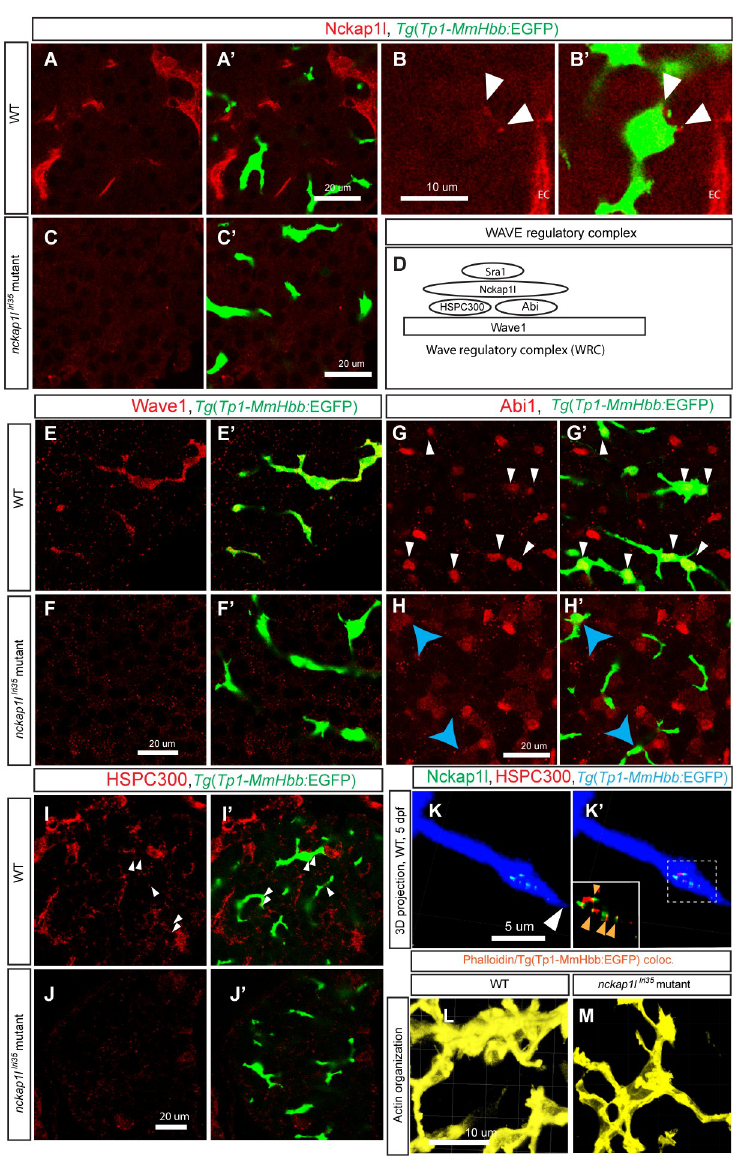
Fig 3. Expression of Nckap1l and other WRC proteins in the liver of wild-type and nckap1l lri35 mutant larvae. (A-C) Z-plane confocal images of the liver visualized for Nckap1l (Red) expression in wild-type (WT) (A and B) and nckap1l lri35 mutant (C) larvae at 5 dpf. Overlay images with biliary epithelial cell marker Tg(Tp1-MmHbb :EGFP ) um14 (Green) shown separately in (A’-C’). Nckap1l is predominantly expressed in endothelial cells in the liver (A), but higher magnification z-plane image (B) shows that Nckap1l is also localized in biliary epithelial cells (white arrowheads). Nckap1l expression is missing in the liver of nckap1l lri35 mutant larvae (C). Ventral views, anterior to the top. EC, endothelial cells. (D-H) Components of the WAVE regulatory complex are degraded in biliary epithelial cells of nckap1l lri35 mutant larvae. (D) Schematic drawing of the WAVE regulatory complex (WRC). This complex acts downstream of Cdk5 and activated Rac1 to stimulate actin remodeling through the actin regulatory complex. The WAVE regulatory complex is a pentameric heterocomplex that consists of WAVE (1, 2 or 3), Abi (1 or 2), Sra1, Nckap1l (or Nap1), and HSPC300. (E and F) Z-plane confocal images of the liver visualized for WAVE1 expression (Red) in WT (E) and nckap1l lri35 mutant (F) larvae at 5 dpf. Overlay images with biliary epithelial cell marker Tg (Tp1-MmHbb :EGFP ) um14 are shown separately in (E’ and F’). WAVE1 is expressed predominantly in biliary epithelial cells in WT larvae; however, in nckap1l lri35 mutant larvae, WAVE1 expression disappears from biliary epithelial cells, suggesting that WAVE1 undergoes degradation in biliary epithelial cells. (G and H) Z-plane confocal images of the liver visualized for Abi1 expression in WT (G) and nckap1l lri35 mutant (H) larvae at 5 dpf. Overlay images with biliary epithelial cell marker Tg(Tp1-MmHbb :EGFP ) um14 are shown separately in (G’ and H’). Abi1 localizes to the nuclei of hepatocytes and biliary epithelial cells (white arrowheads) in the wild-type liver. However, in the liver of nckap1l lri35 mutant larvae, Abi1 staining in the nuclei of biliary epithelial cells is lost (yellow arrows), while Abi1